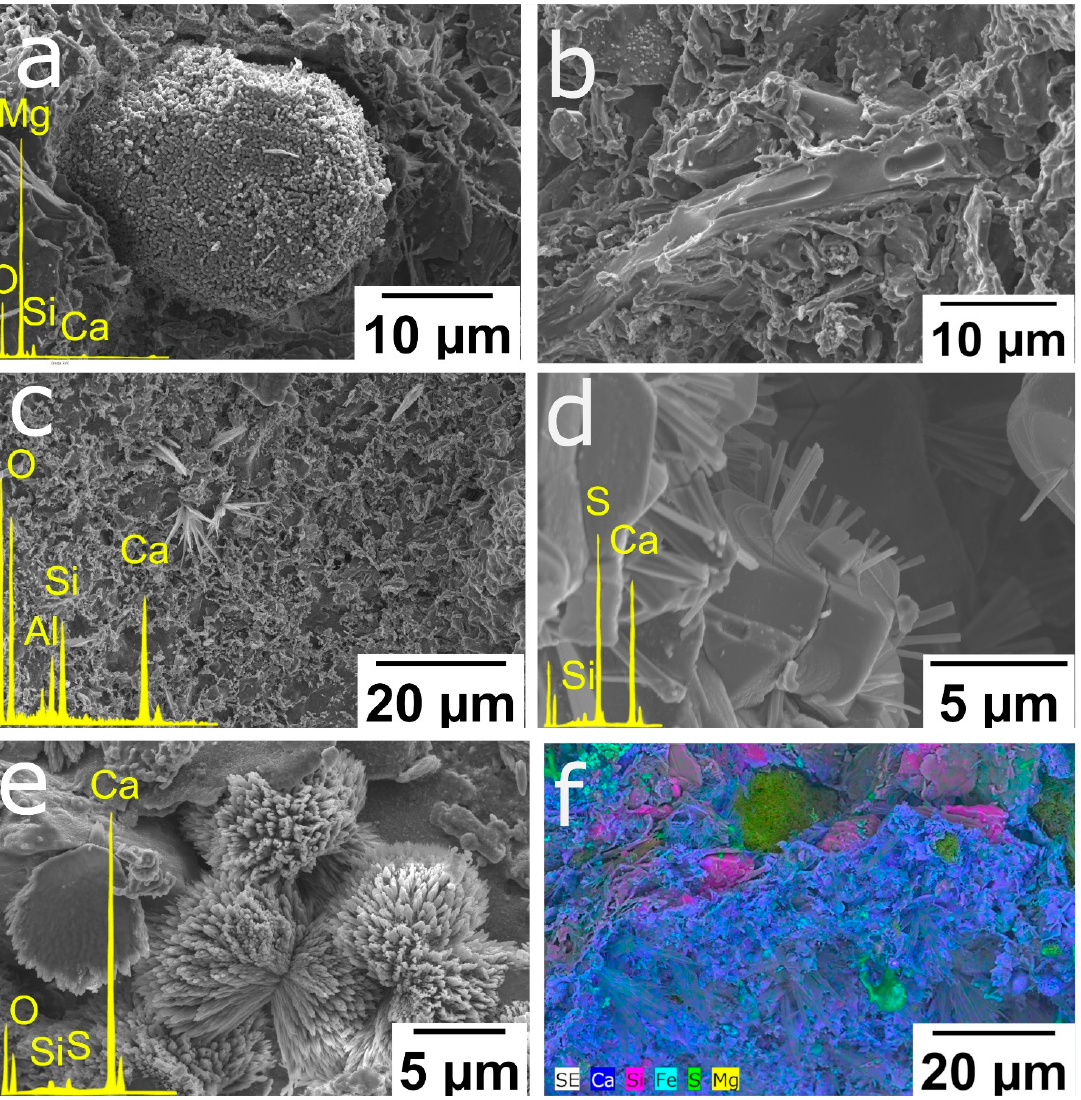
Figure 5. ESEM secondary electron images of fired bricks: ( a ) rounded Mg oxide from a former dolomite grain with the presence of nanocrystals on the surface (P2); ( b ) view of partially vitrified matrix in which smooth surfaces and rounded pores can be seen (H2); ( c ) micrometric gehlenite crystals covering a pore surface (P2); ( d ) development of secondary gypsum crystals on anhydrite grains (H2); ( e ) growth of secondary calcite crystals with scalenohedral habit (H6); ( f ) compositional map of a section close to a sample pore